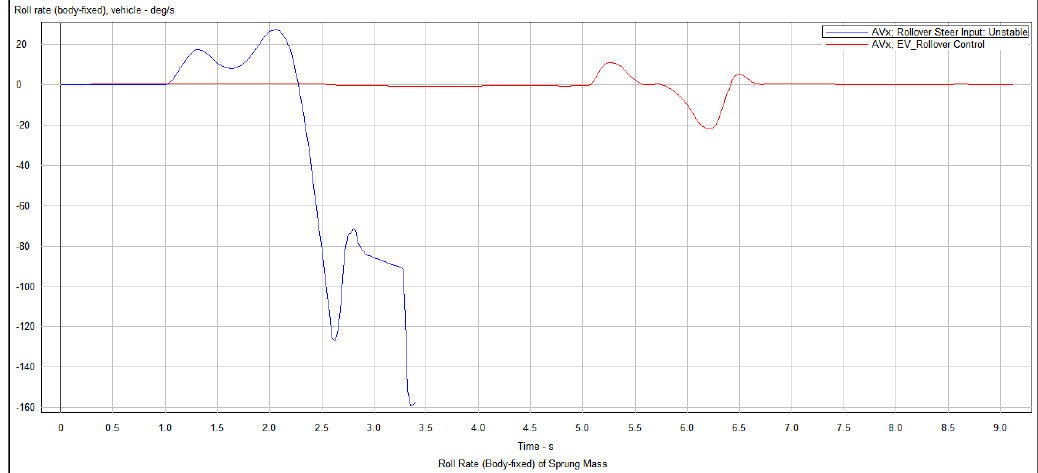
Figure 7. Roll angle comparison curve for fishhook test.